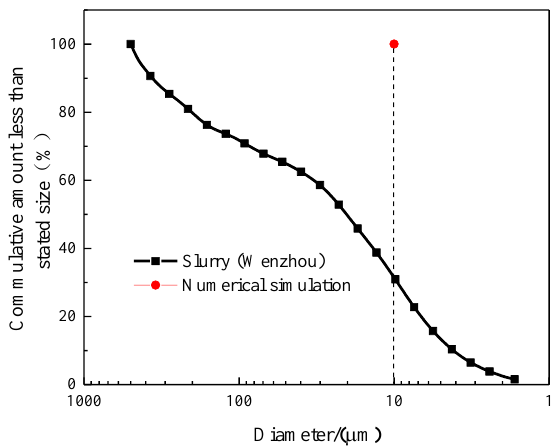
Figure 7. Particle size distribution of dredged slurry sampled from Wenzhou. One of the commonly used tracers is dark carbon powder that has a minimum di- ameter of about 16 μm. Correspondingly, tracers of three diameters were considered in the model, i.e., d t = 16, 18, and 25 μm. Additionally, two mass densities ρ t = 2000 and 2650 kg/m 3 were specified for the tracer to consider the tracers of different material origin, e.g., carbon powders and sand grains. Under the different combinations of the initial void ra- tio e 0 of the slurry, the diameter d t and the mass density ρ t of the tracer, 8 modeling cases were considered in the present paper, which is summarized in Table 4, together with the geometry and material parameters of the solid and fluid phases. The different cases can cover a wide spectrum of the PIV model tests on the dredged slurry. Table 4. Modeling cases and parameters of dredged slurry and PIV tracers. Parameter